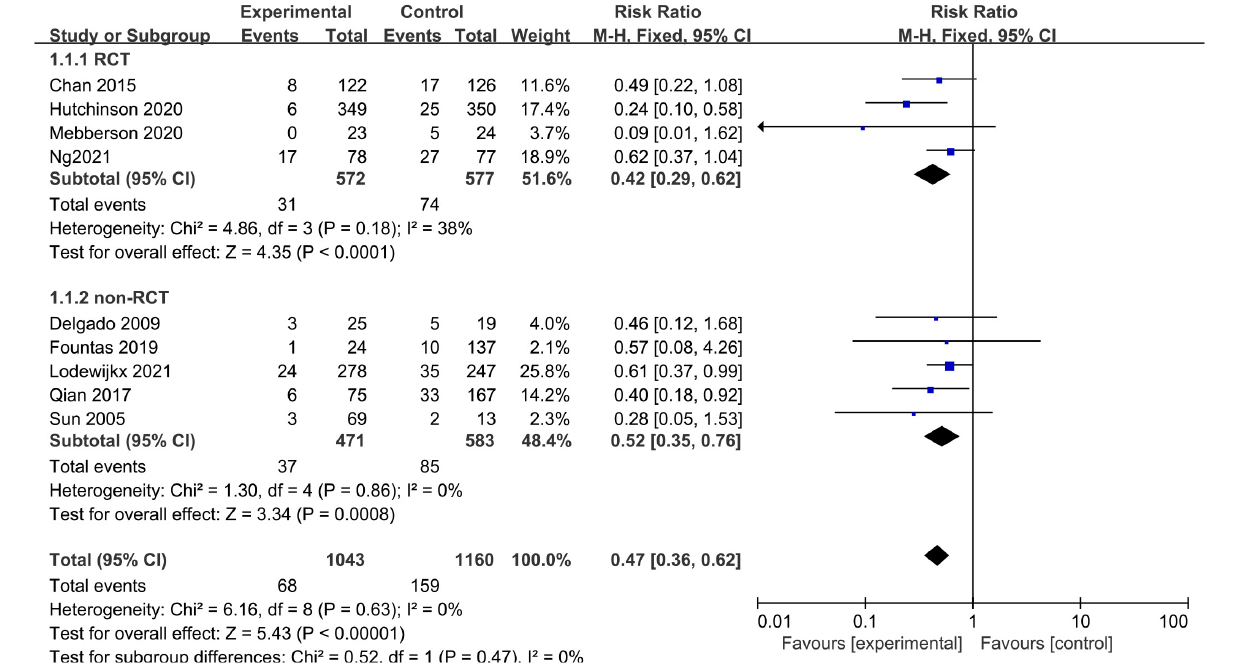
Frontiers in Neuroscience |